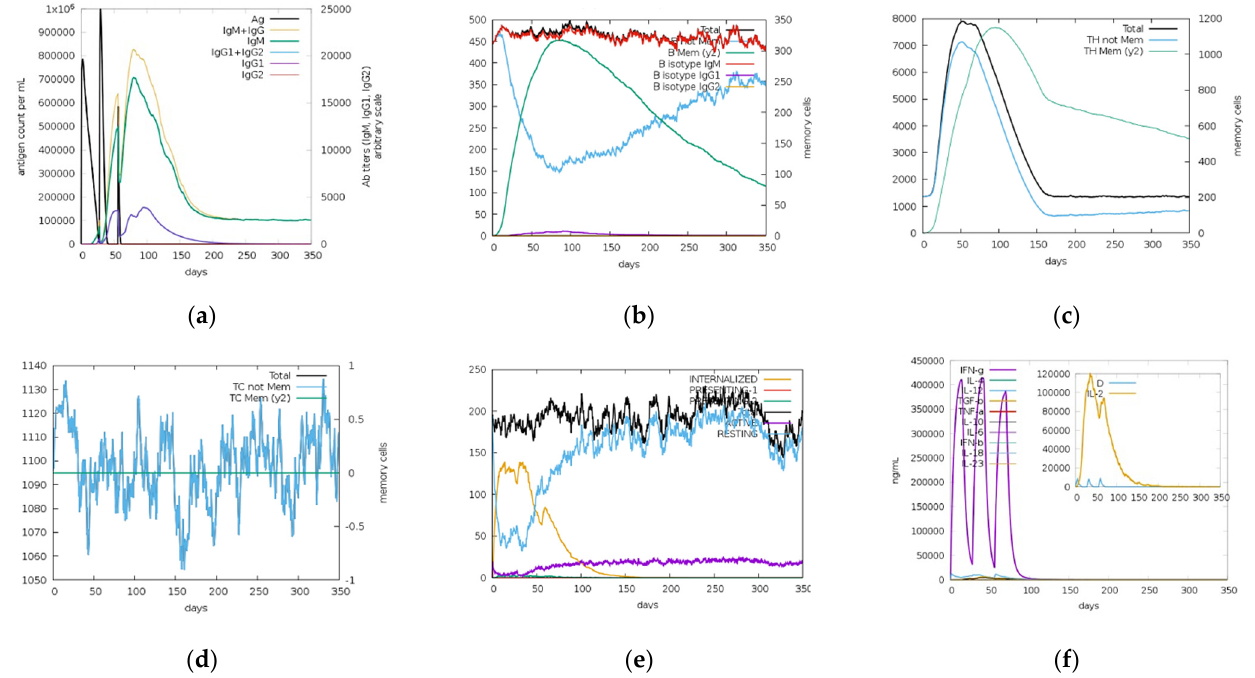
Figure 12. C-ImmSim server predictions for EIII protein: ( a ) immunoglobulins (IgG1, IgG2, IgM, IgG, IgM, and antigens); ( b ) memory cell (B-cell) population; ( c ) helper T cell (HTL) population; ( d ) cytotoxic T cell (CTL) population; ( e ) macrophage count per state; ( f ) cytokine and interleukin (IL) production with Simpson index (D) of the immune response.